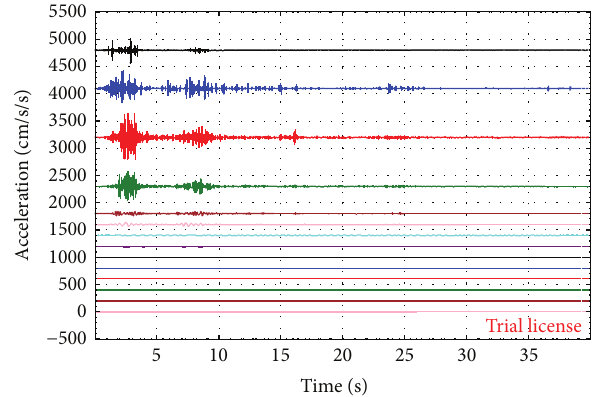
Figure 8: Acceleration time history of IMF.